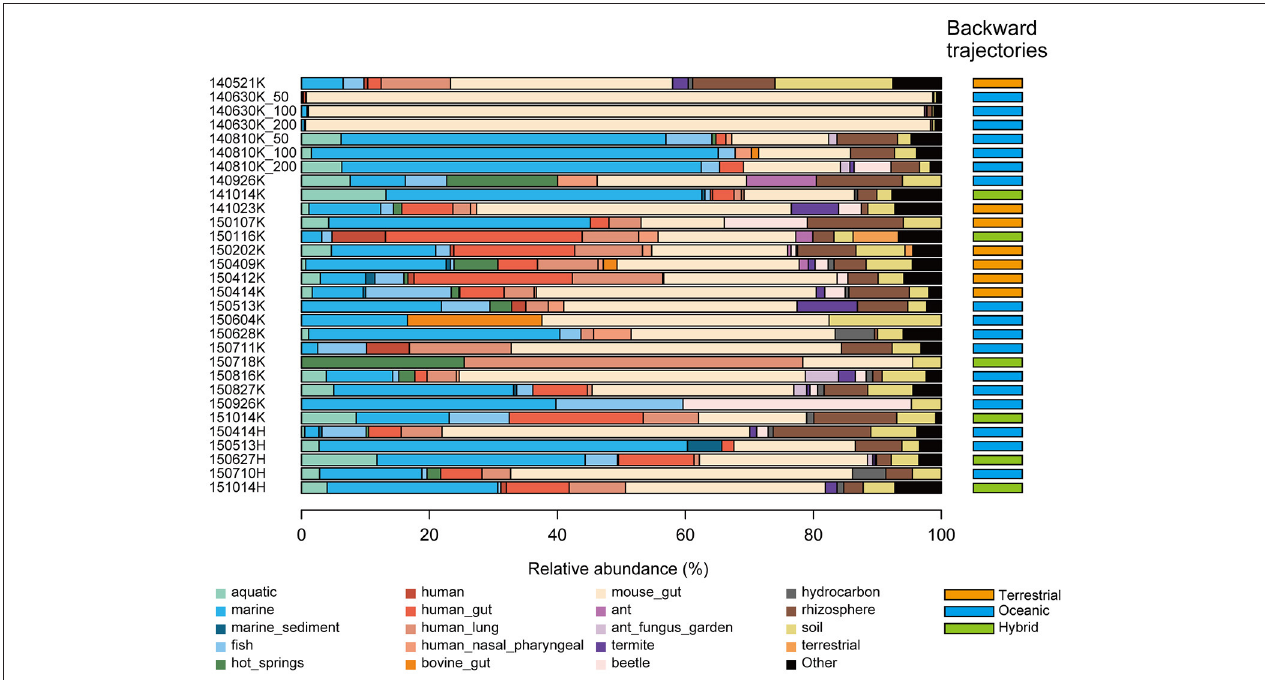
FIGURE 5 | Estimated ordinary habitats of precipitation microbes. Because the ordinary habitat for an individual 16S rRNA sequence cannot be conclusively determined, the microbial habitability index (MHI) was calculated to estimate the probability of an ordinary habitat (Yang and Iwasaki, 2014). Estimated ordinary habitats demonstrating < 5% abundance were summarized as “Others.” The estimated route of the air mass before each precipitation event is indicated in the right column. The terrestrial, oceanic, and hybrid routes are colored in orange, blue, and green, respectively. The estimated air mass backward trajectory maps are provided in Supplementary Figure S3 .